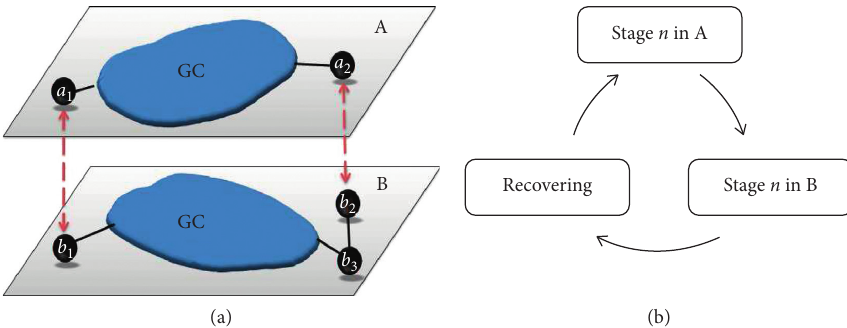
Figure 2: The schematic demonstration of the self-awareness recovery model. (a) The nodes a 1 and b 1 are mutual boundary nodes of subnetwork A at the distance d but a 2 and b 2 do not belong to mutual boundary of subnetwork B because the distance d from b 2 to giant component is 2. If at least one pair of failed nodes is at the distance d > 1 from its giant component, then these nodes cannot be recovered in this stage. (b) The procedure of self-awareness recovery model on interdependent networks.